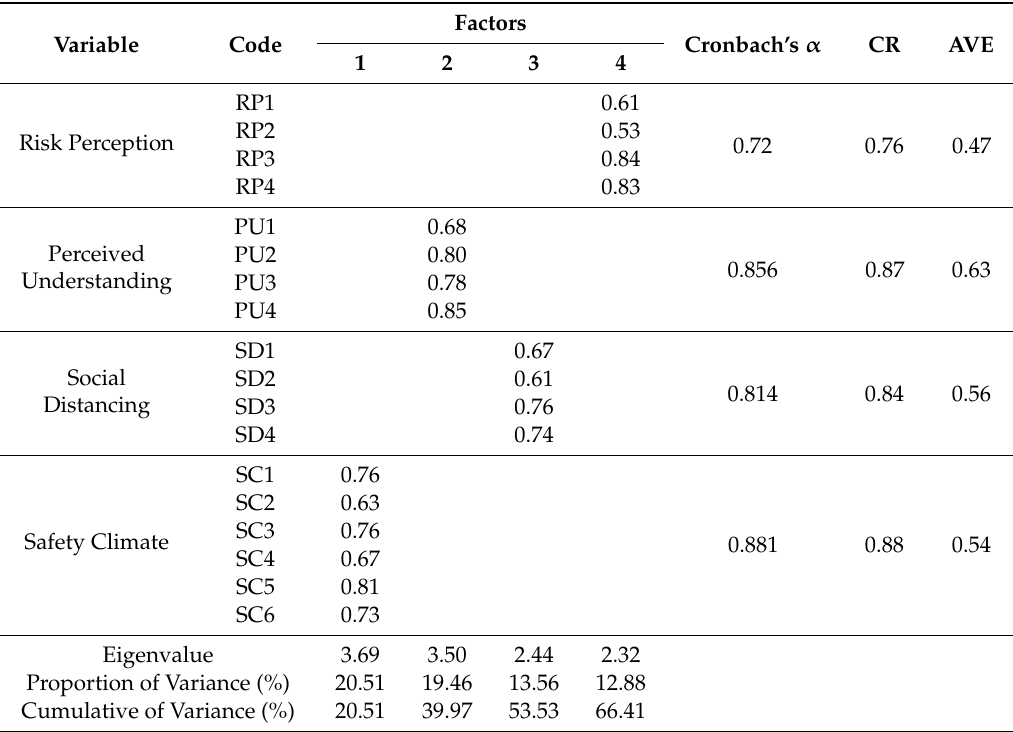
Table 4. Results of reliability and validity